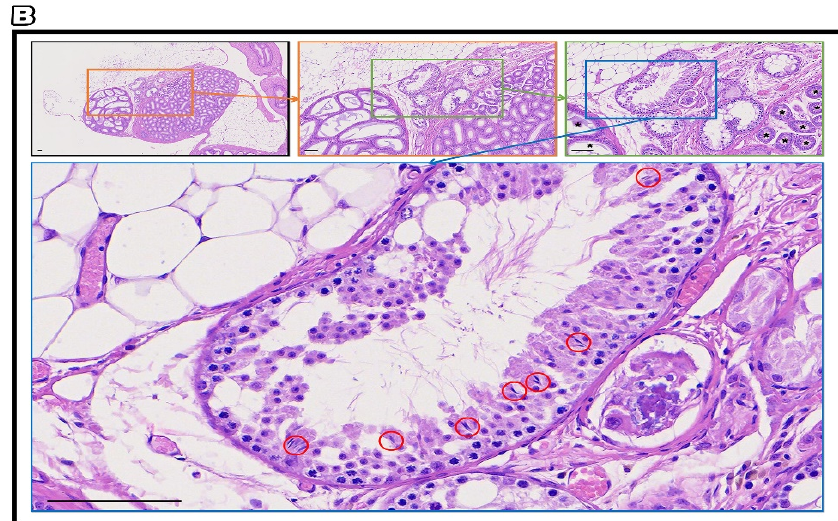
Figure 7. The gradual magnification of testicular tissue containing intact connection seminiferous tubules with epididymis showed progressive spermatogenesis with germ cells, especially mature sperm marked in the red circle in fresh grafts ( A ) and SSV grafts ( B ), bar = 100 µm.